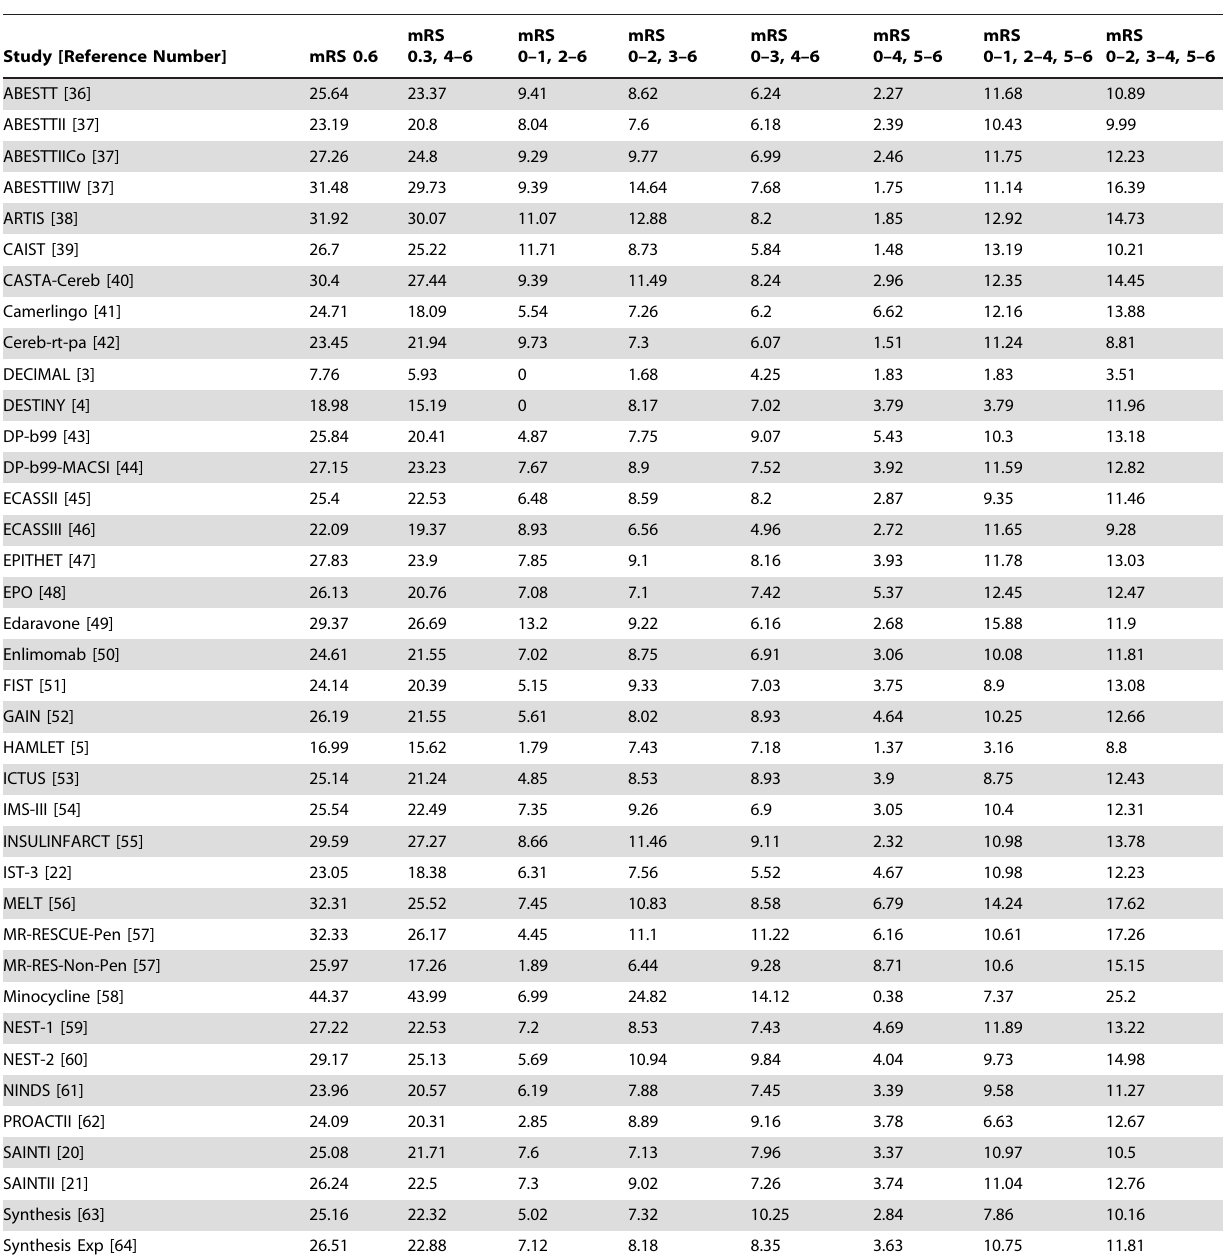
Table 1. Error percentages for 38 studies for the full ordinal scale (mRS 0.6), partially collapsed ordinal scale (mRS 0.3, 4–6) and dichotomization (mRS 0–1, 2–6; mRS 0–2, 3–6; mRS 0–3, 4–6; mRS 0–4, 5–6) and trichotomization (mRS 0–1, 2–4, 5–6; mRS 0–2, 3–4, 5–6)